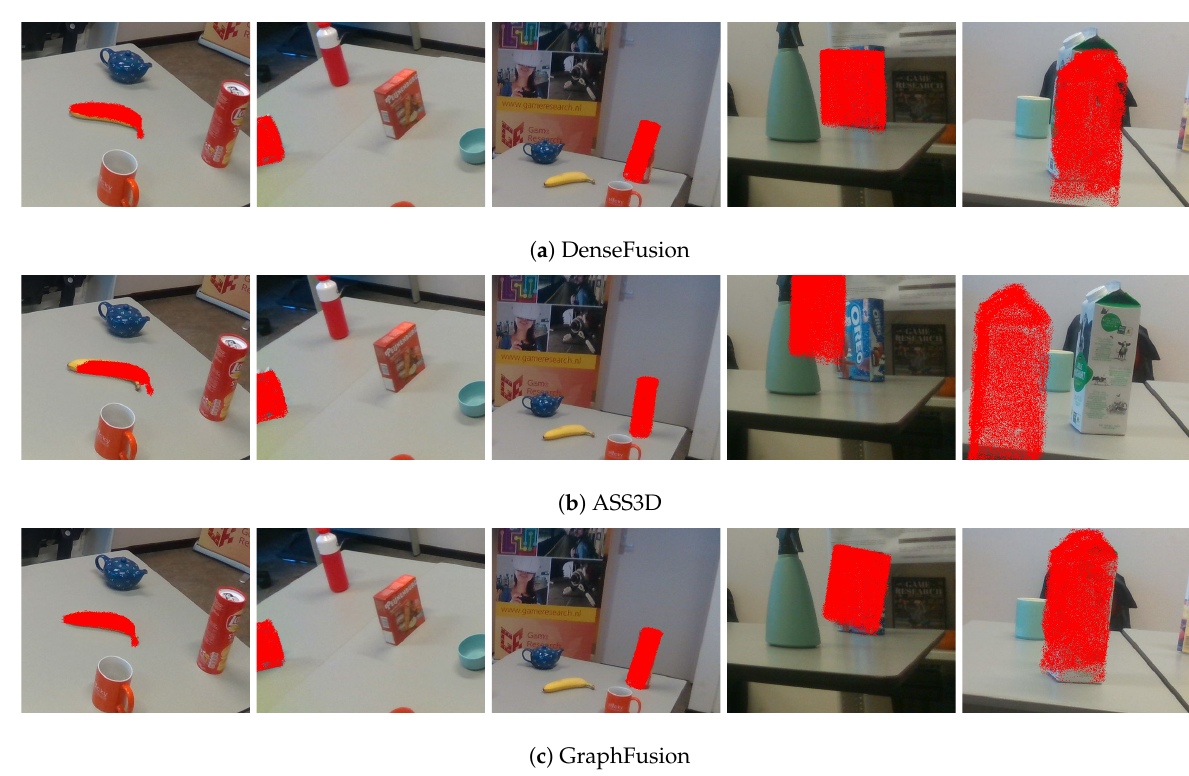
Figure 15. Examples of accuracy performance. Each 3D model is projected to the image plane with the estimated 6D